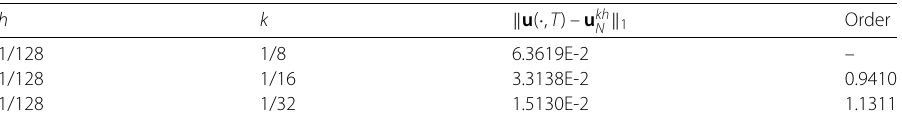
Table 3 Convergence orders of the errors with fixed spatial step-size h